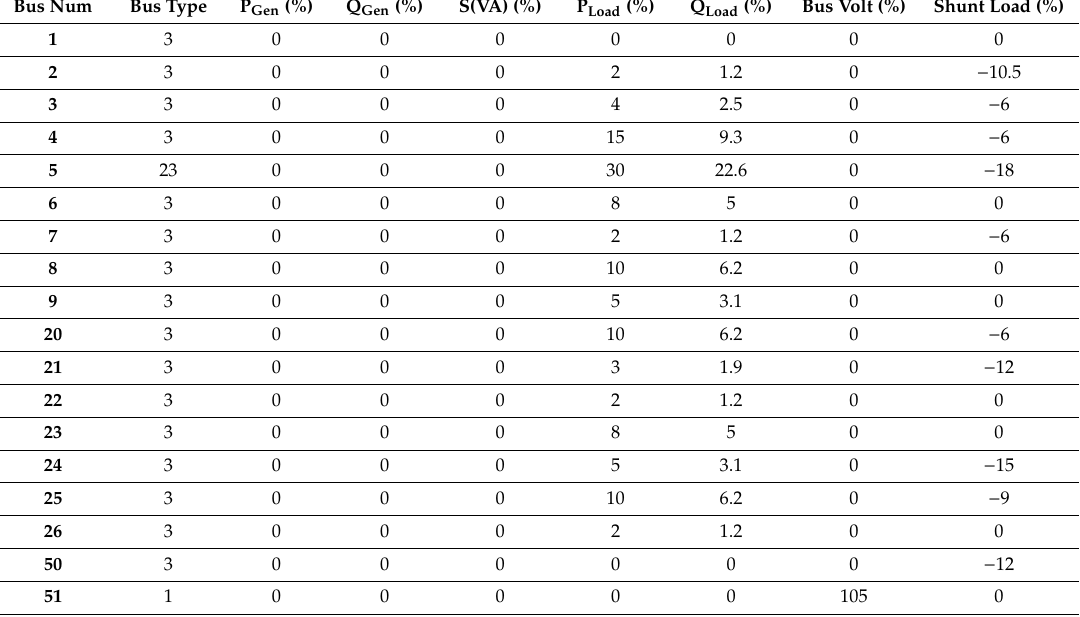
Table A2. Bus information for the 18-bus IEEE standard